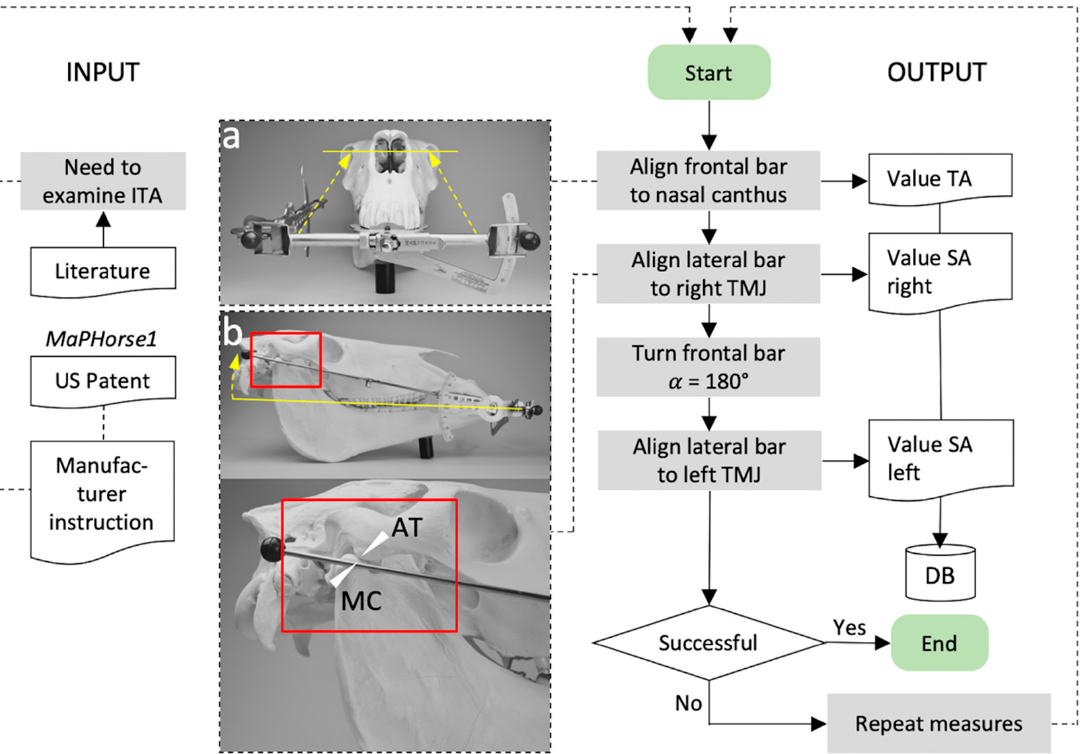
Figure 4. Flow chart of incisor table angle measures using MaPHorse1 in this validation study. ( a ) Frontal bar alignment to measure the transversal angle (TA). ( b ) Lateral bar alignment to measure the sagittal angle (SA). The lateral bar is centered between the Tuberculum articulare of the Processus zygomaticus ossis temporalis = articular tubercle (AT) and Caput mandibulae of the Processus condylaris mandibulae = mandibular condyle (MC) after transcutaneous palpation. ITA, incisor table angle; DB, database.